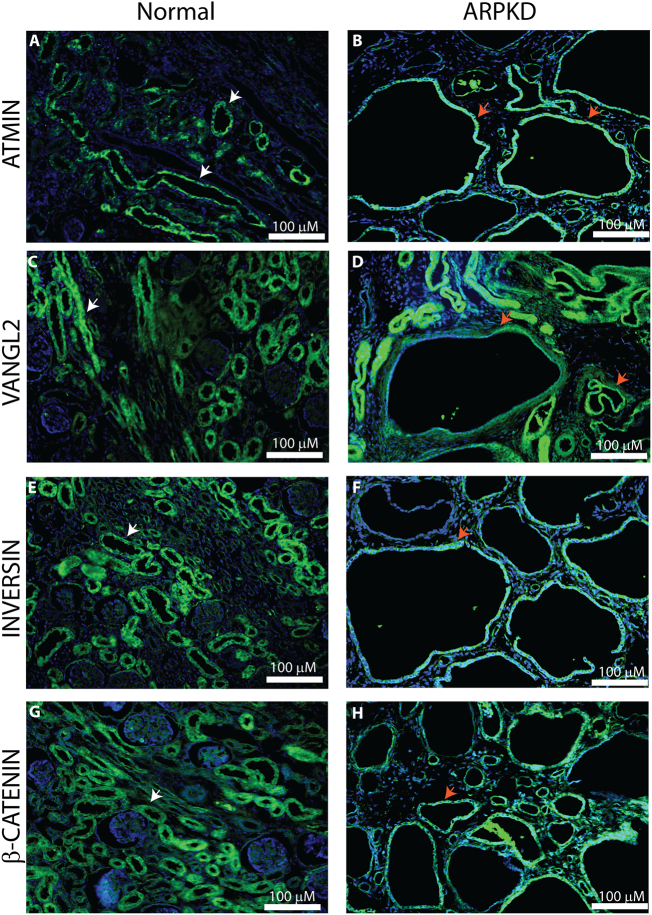
Immunohistochemistry of Wnt signalling proteins reveals differential localisation patterns between paediatric normal and ARPKD kidneys. ATMIN (A), VANGL2 (C), Inversin (E) and β-catenin (G) were expressed in ureteric bud-derived collecting tubules in normal human paediatric kidneys (white arrows). In age-matched ARPKD kidneys, strong ATMIN (B) and VANGL2 (D) expression was detected in cyst-lining epithelia (orange arrows). Moderate Inversin (F) and β-catenin (H) expression was also observed in ARPKD cyst-lining epithelia (red arrows; n = 4 per group).